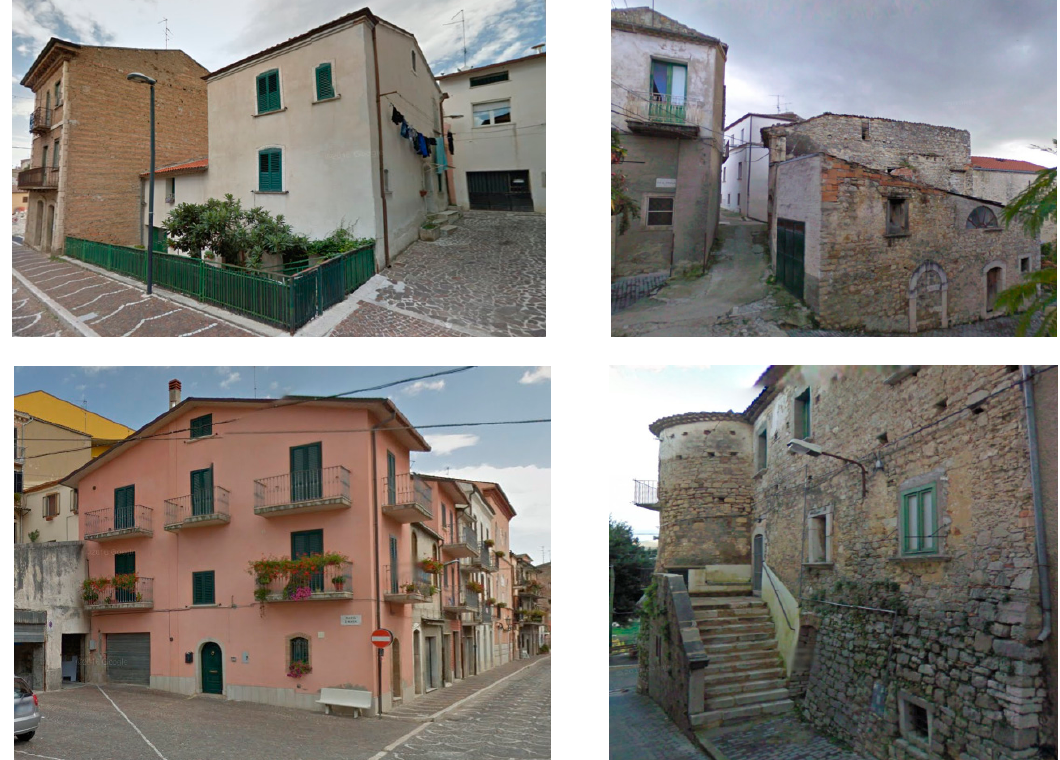
Figure 6. Street views of some building typologies inside the inspected historical centre of Baranello.